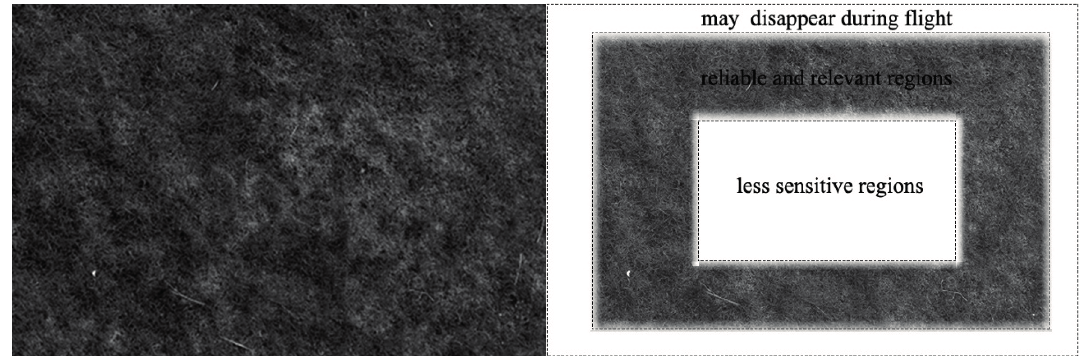
Figure 3. ( Left ) An image captured from a downwards looking camera of the miniature flying ball (MFB); ( Right ) Representation of the regions where measurements are both reliable and